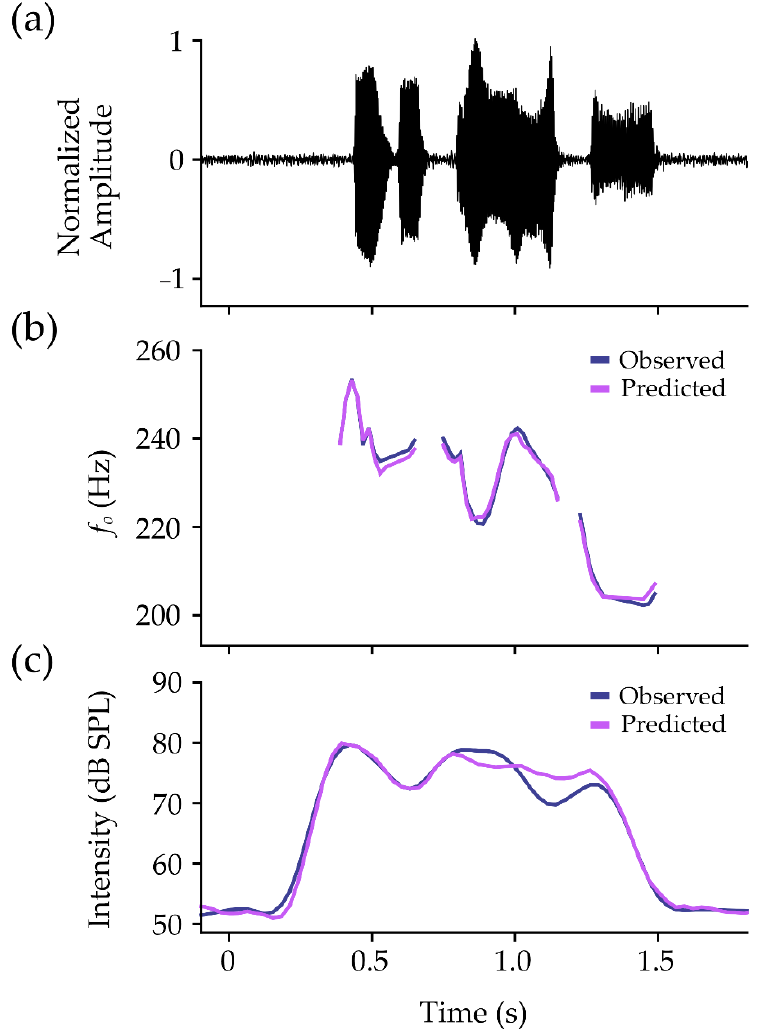
Figure 4. Example data for one participant from the phrase “Easy for you to say.” The normalized microphone signal is shown ( a ), with observed (navy lines) and predicted (pink lines) contours for ( b ) f o and ( c ) intensity. Contours for f o have been converted from semitones to Hertz (Hz) for visualization purposes.